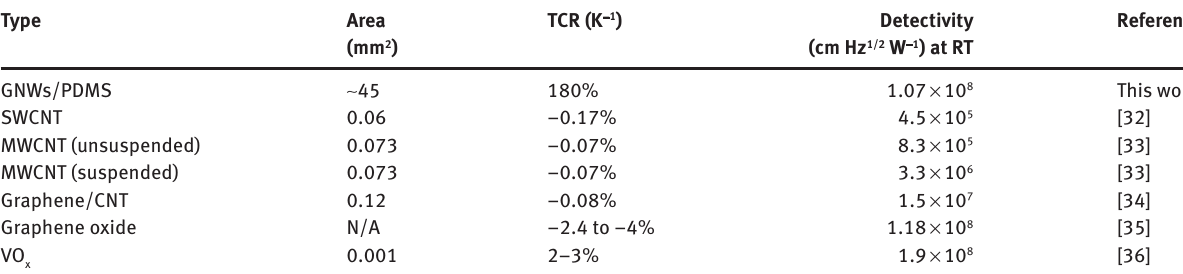
Table 1: Device performance of IR photodetector based on different nanomaterials.